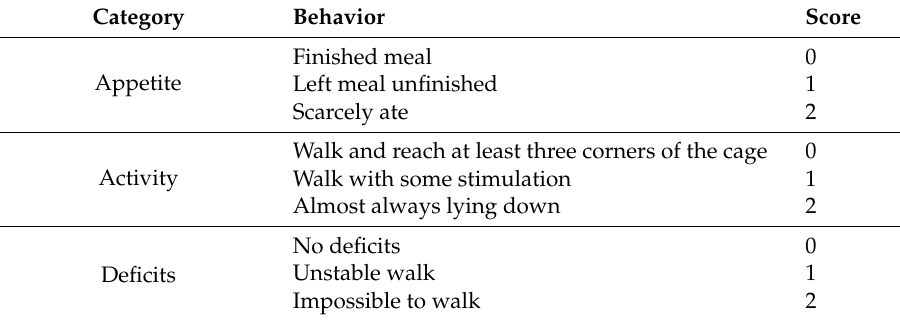
Table 1. Behavior